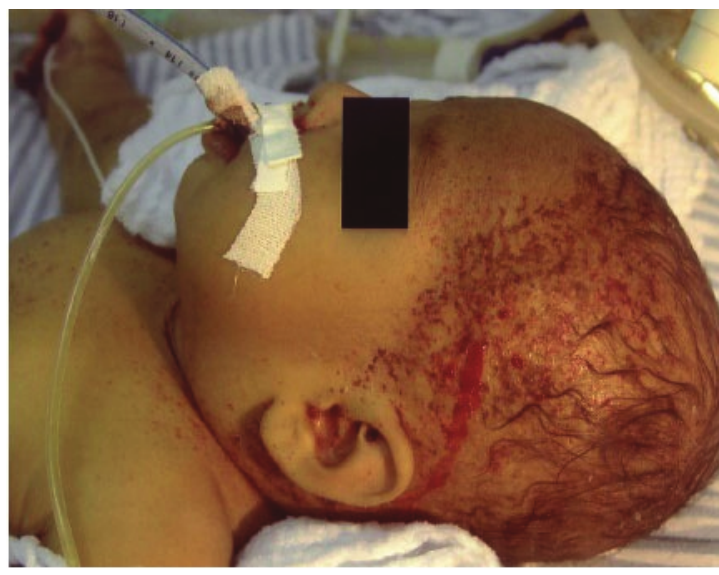
Figure 8: Reported case from Brazil.